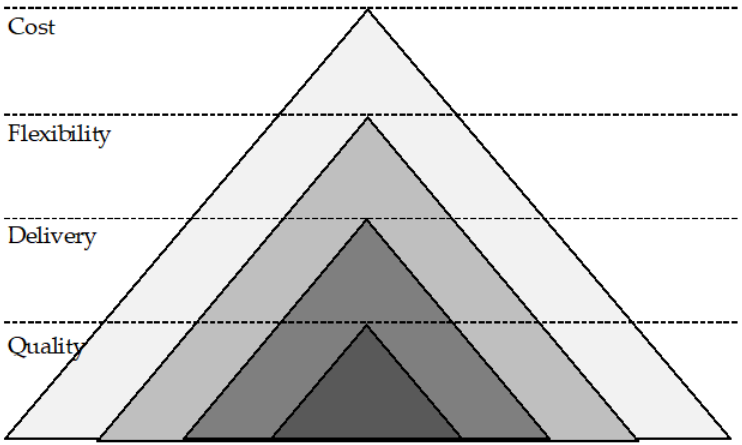
Figure 1. Competitive priorities model. Source: (Bortolotti et al. 2015; Boyer and Lewis 2002).